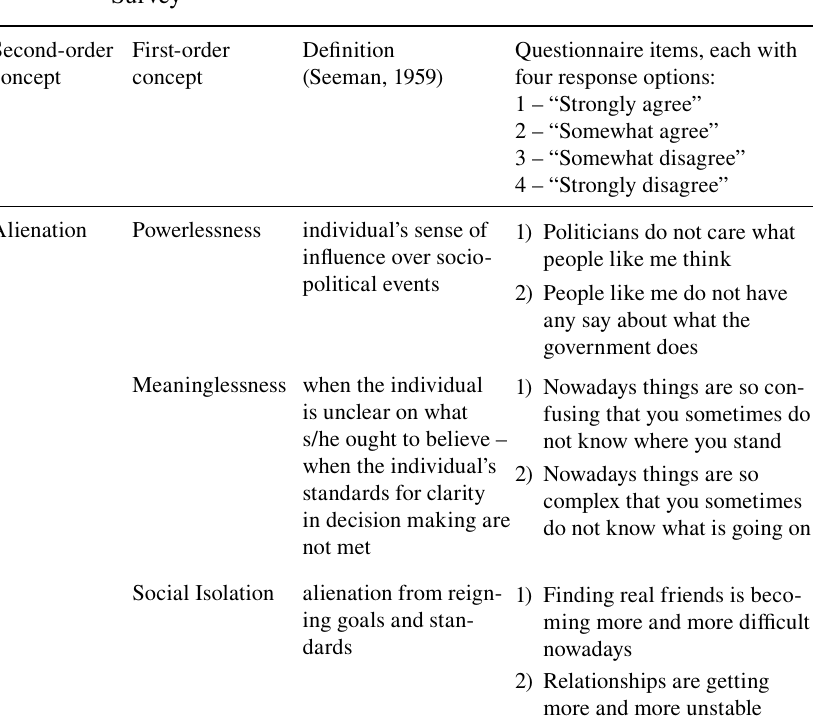
Indicators of Alienation Used in the “Group-Focused Enmity”